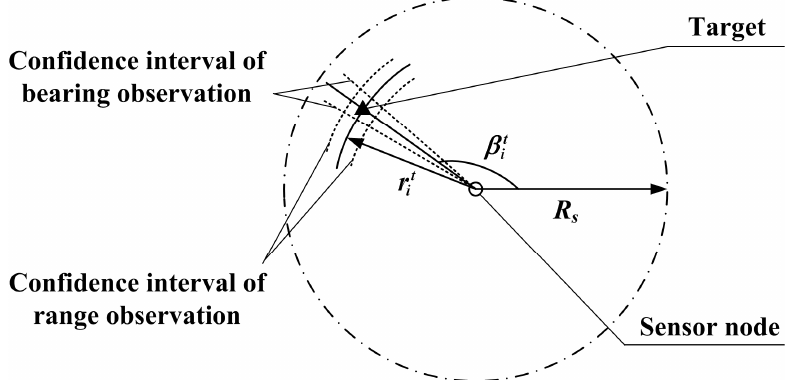
Figure 2. Sensing function of a single sensor